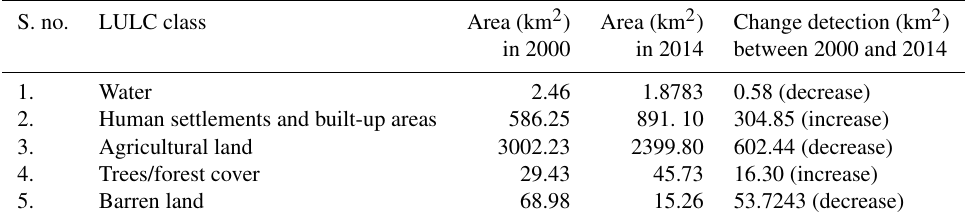
Table 4. Change detection in different LULC (km 2 ) between 2000 and 2014. S. no.